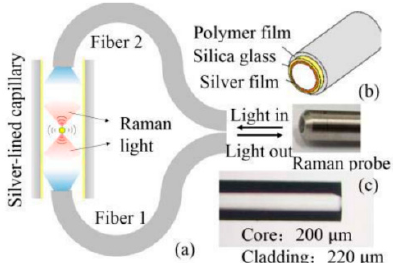
Figure 14. Sagnac ring experimental device diagram. ( a ) Sagnac loop diagram. ( b ) Capillary diagram. ( c ) Large-core diameter fiber after cutting. © (2018) IEEE. Reprinted, with the permission, from [32].